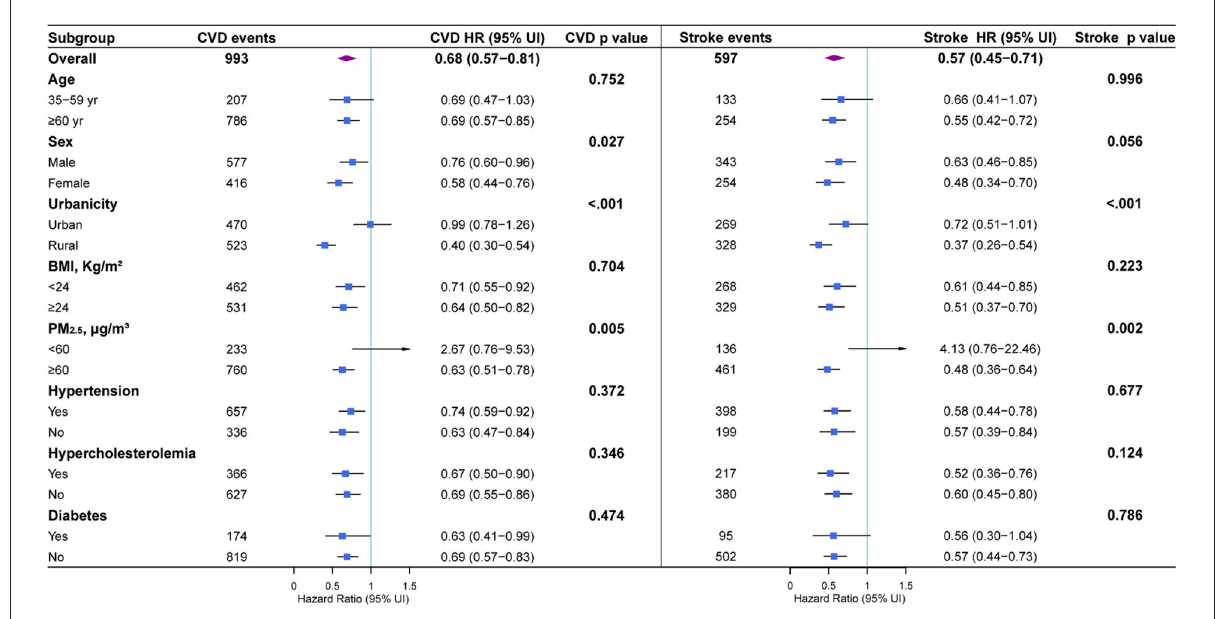
FIGURE4 Subgroup analyses for full-adjusted hazard ratios (95% CIs) of fatal or nonfatal CVD and stroke with the best tertile compared to the worst tertile in annual blue day